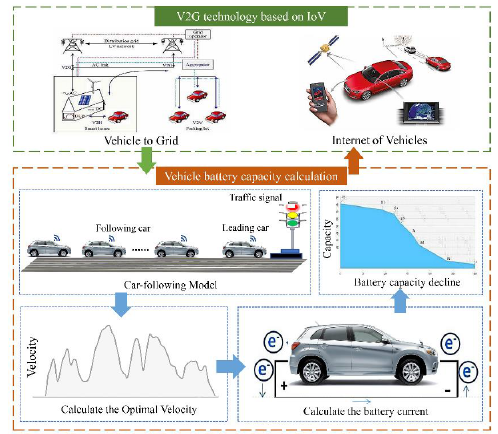
Figure 1. Main research methods.